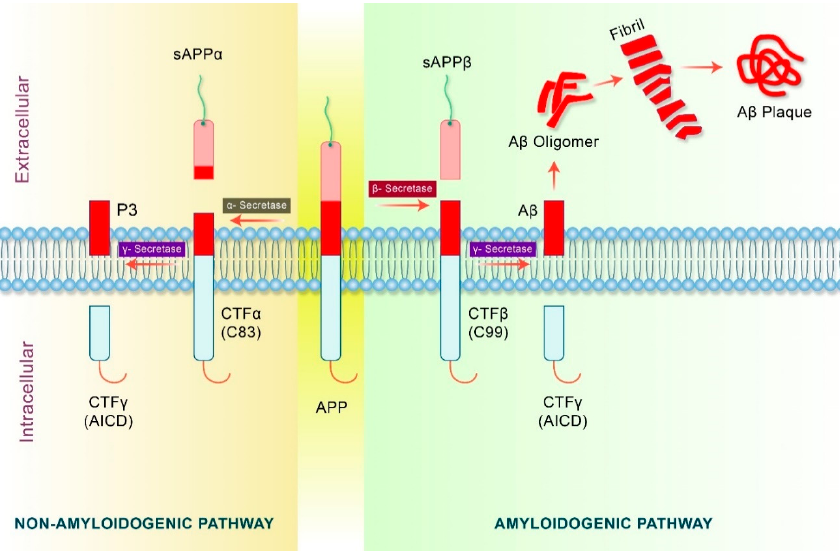
Figure 3. APP processing pathways in AD. APP are generally processing in two different pathway, amyloidogenic and non-amyloidogenic. In the non-amyloidogenic pathway, APP is cleaved by α -secretase to form two fragments, an intracellular C-terminal fragment α (CTF α ), C83, and an extracellular fragment, soluble amyloid precursor protein α (sAPP α ). Cleavage of C83 fragment via γ -secretase yields a short peptide fragment, P3, and an APP intracellular domain (AICD). In the amyloidogenic pathway, APP is cleaved by β -secretase which produces a soluble amyloid precursor protein β (sAPP β ) and a C-terminal fragment β (CTF β ) or C99 fragment. C99 fragment is cleaved by γ -secretase to produce A β and C-terminal fragment γ (CTF γ ) or AICD. A β further forms A β oligomers which subsequently results in the formation of fibrils and neurotoxic A β plaques extracellularly.